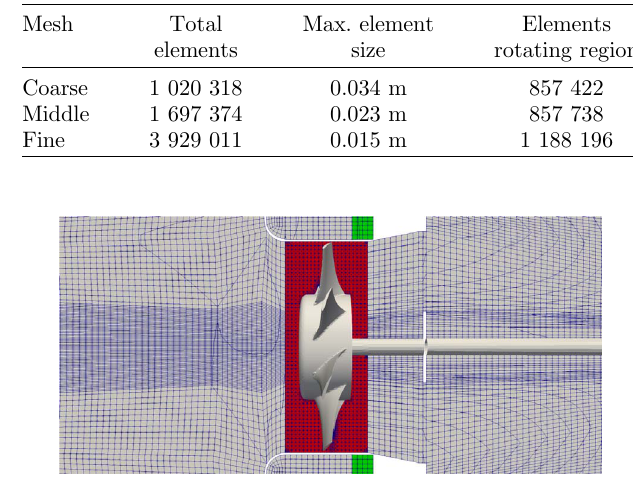
Figure 19. Acoustic mesh, with pure hexahedral meshes in the inlet and outlet region (gray) and a tethrahedral mesh in the rotating region